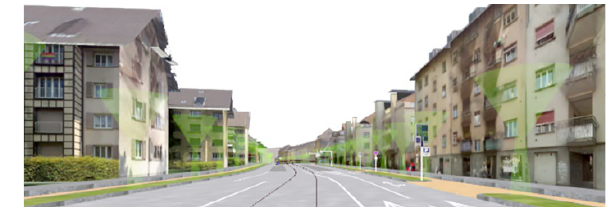
Figure 8. City model facades textured by MMS images